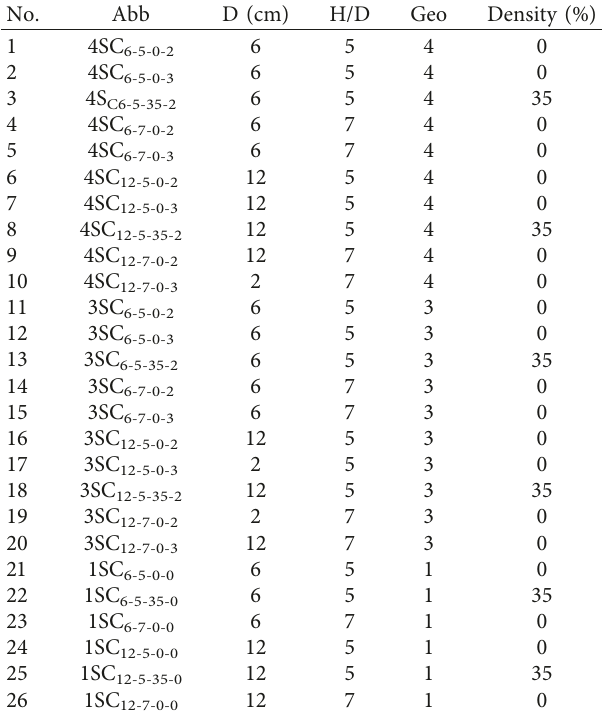
Table 2: Introduction of the studied modes in the present